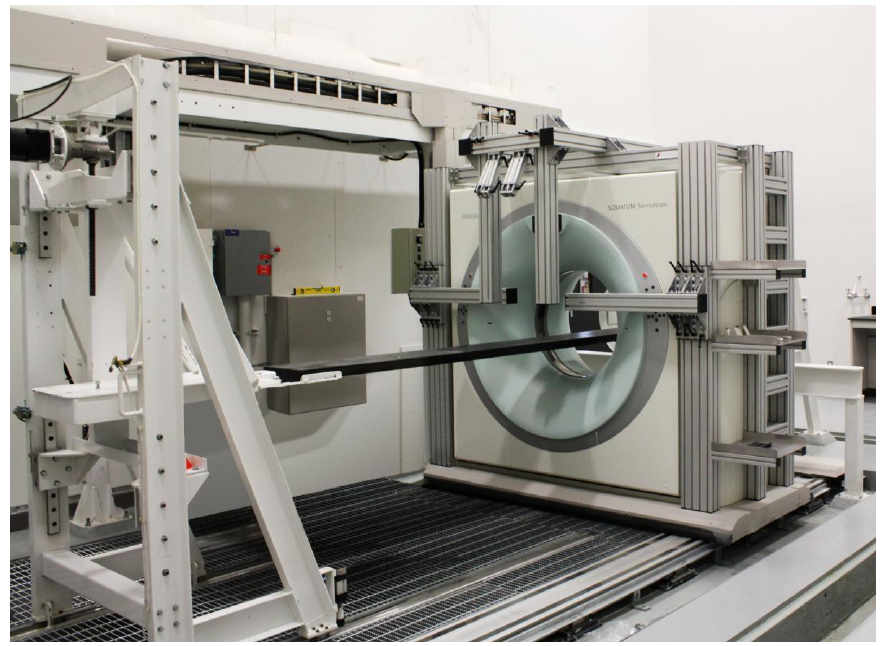
Figure 1. Siemens Somatom Sensation 64 designed for the human body but adapted for material research. Courtesy of INRS-ETE, Quebec, QC, Canada.